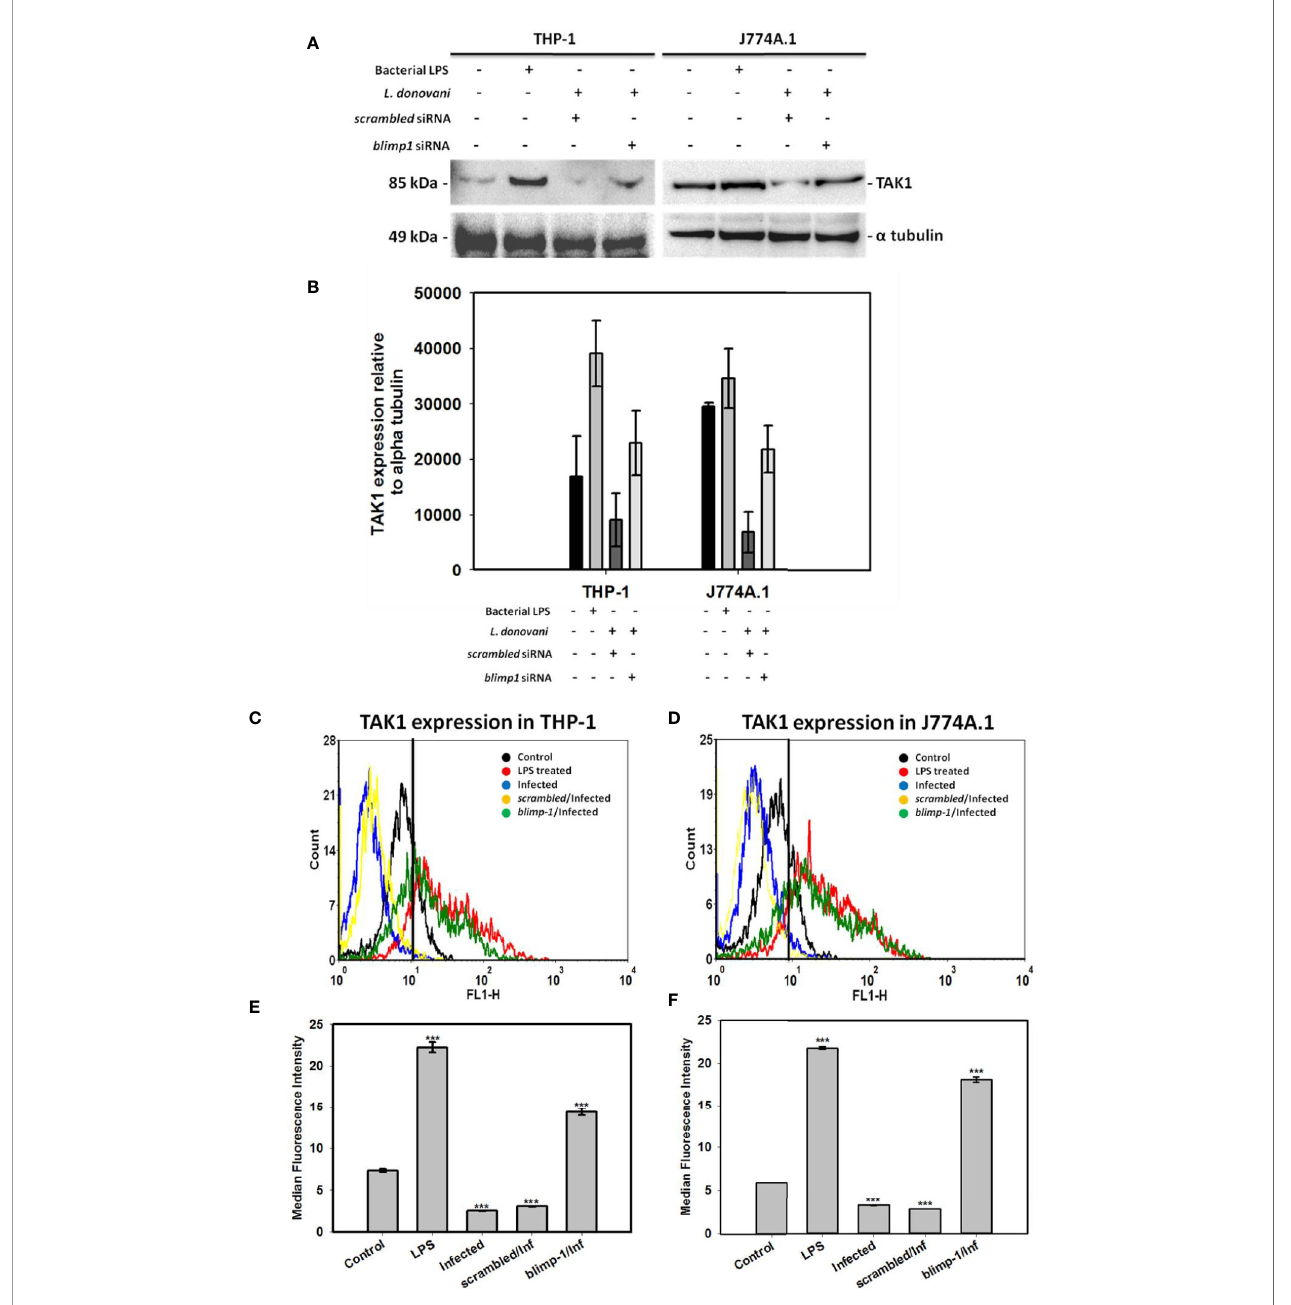
FIGURE 2 | Quanti fi cation of TAK1 expression in blimp-1 de fi cient cells infected with promastigotes at MOI of 1:5 for 24 h in both THP-1 and J774A.1 cell lines were measured using immunoblotting and fl ow cytometry. Bacterial LPS treated cells were used as positive controls for the experiment; (A) Western Blot, (B) Densitometry analyses of TAK1 expression. For fl ow cytometry, overlaid histogram plot was shown for (C) THP-1 cells and (D) J774A.1 stained cells. Median Fluorescence Intensity (MFI) has also been plotted for (E) THP-1 and (F) J774A.1 cells. (Note: n = 2 for (A, B) and n = 3 for (C – F) , where n represents different independent experimental replicates for all the experiments; *** denotes p < 0.001; percentage of gated cells is 100% and total event counted is 2500 for all fl ow cytometry